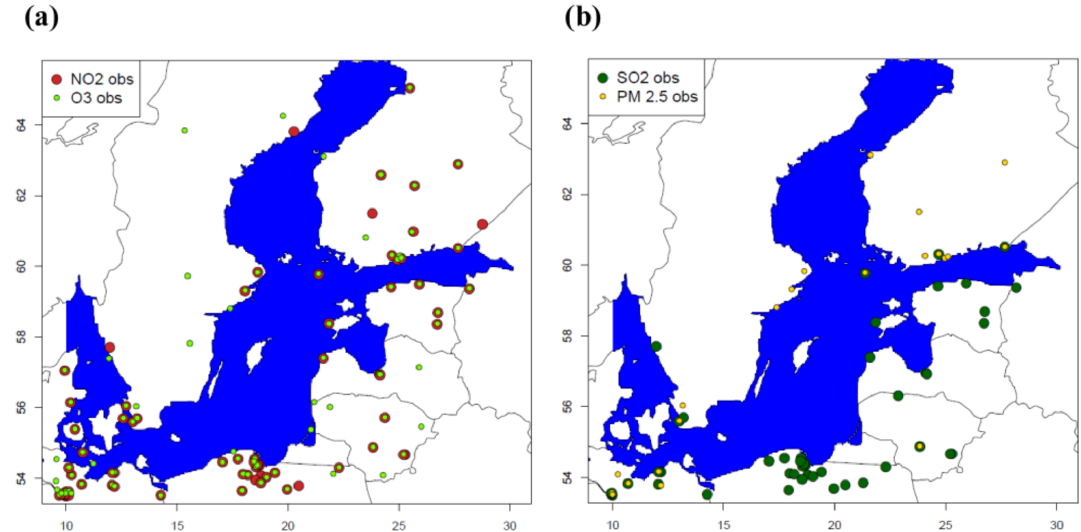
Figure 2. Map of the Baltic Sea region with the location of background monitoring stations used in the statistical performance analysis with observations of (a) NO 2 (filled red circles), O 3 (filled green circles), (b) SO 2 (filled dark green circles) and PM 2 . 5 (filled yellow circles). Same domain as in Fig.